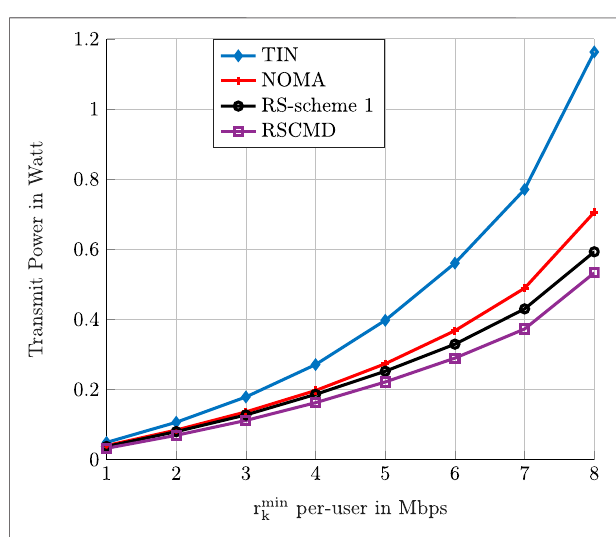
FIGURE 9 | The optimal value of the optimization problem (P 2 ) as a functionofthenumber ofusers. We compare theperformanceofTIN,NOMA, RS-scheme 1, and RS – CMD transmission strategies.